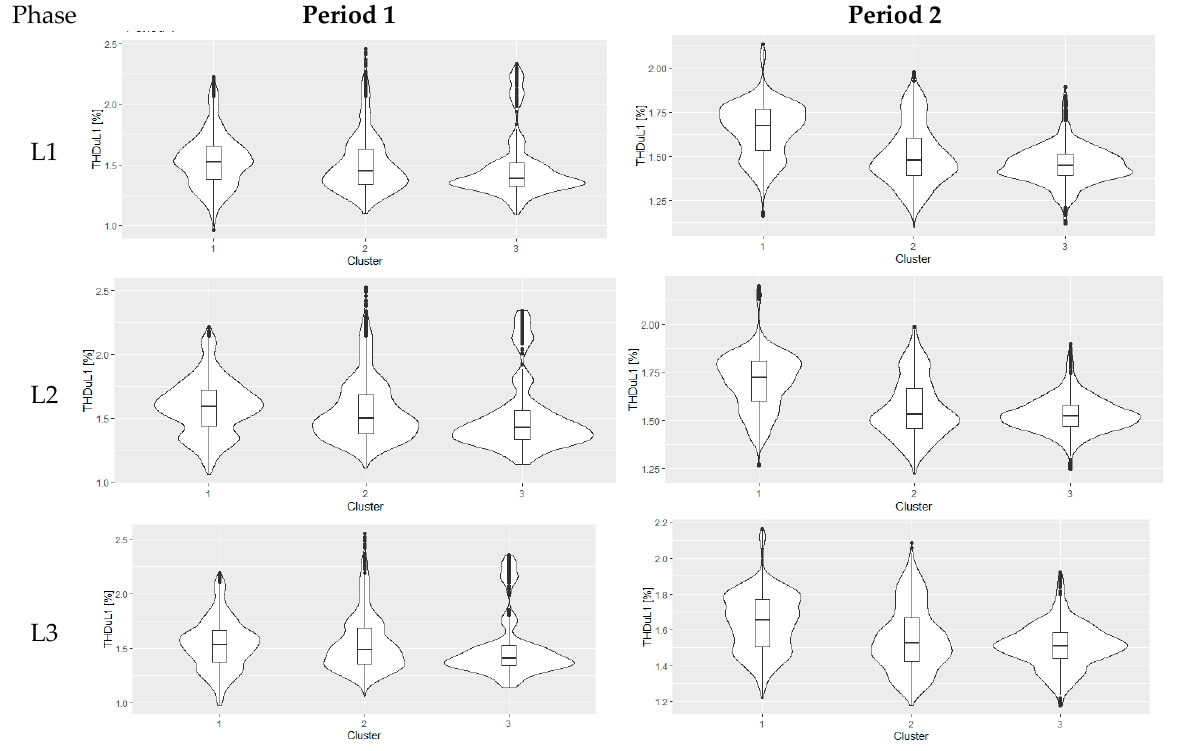
Figure 13. Violin plots of THDu comparing clusters for Period 1 and Period 2 in each phase. The statistical tests and test hypotheses show that the THDu coefficient varies (red, Table 21) between Periods 1 and 2 for all clusters. The THDu coefficient improved in Pe- riod 2, especially for Cluster 3, which has a smaller maximum value, and a narrower value variation band and shifted closer to zero. The results of the Wilcoxon rank-sum test are shown in Figure 13.